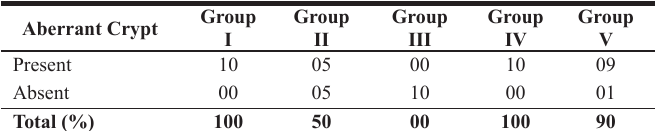
TABLE 1 – Animals per group according to the presence or not of histological changes (n=10)